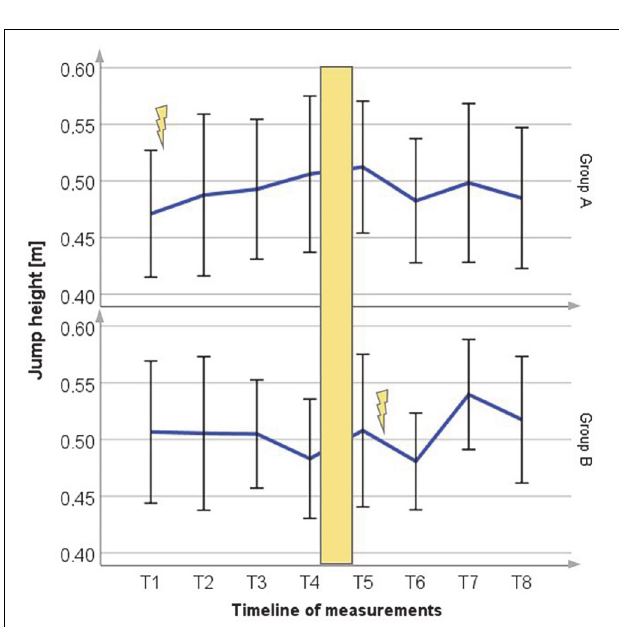
FIGURE 4 | Mean ( ± SD) change in sprint time for Group A period 1 and Group B period 2, compared to each control group ( p = 0.02). Lightning bolt represents each respective WB-EMS period; yellow area = wash-out phase.